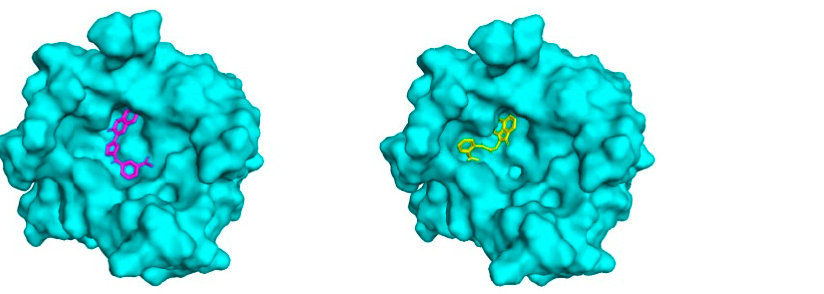
Figure 4. Molecular model and docking of ZINC00784494 and ZINC00640089 ligands into LCN2- calyx pocket. ( A ) Surface model representation of LCN2-calyx pockets. Pockets #1, #2, and #3 (dotted circles) are represented with key amino acid residues in yellow color (right panel). ( B ) Cartoon docking representation and predicted binding interactions of ligands with key residues of LCN2- calyx pocket. Interactions are represented with yellow dotted lines. Residues are displayed with a three-letter code and numbers representing the position in the polypeptide. ( C ) Surface docking representation of ligands (represented as sticks) ZINC00784494 (magenta) and ZINC00640089 (yellow) into the LCN2-calyx pocket.